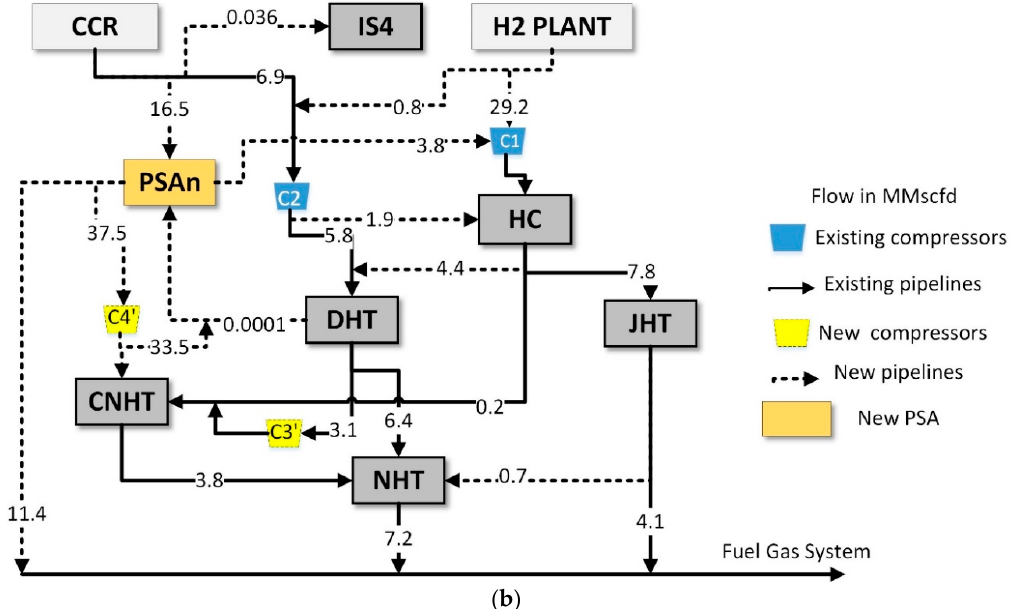
Figure 6. ( a ) Optimized network HN2 via HNS NLM for example 1. ( b ) Optimized network HN3 via HNS NLM with HNS LM as initialization, for example 1. Table 4. Results obtained in the different optimizations models for example 1.